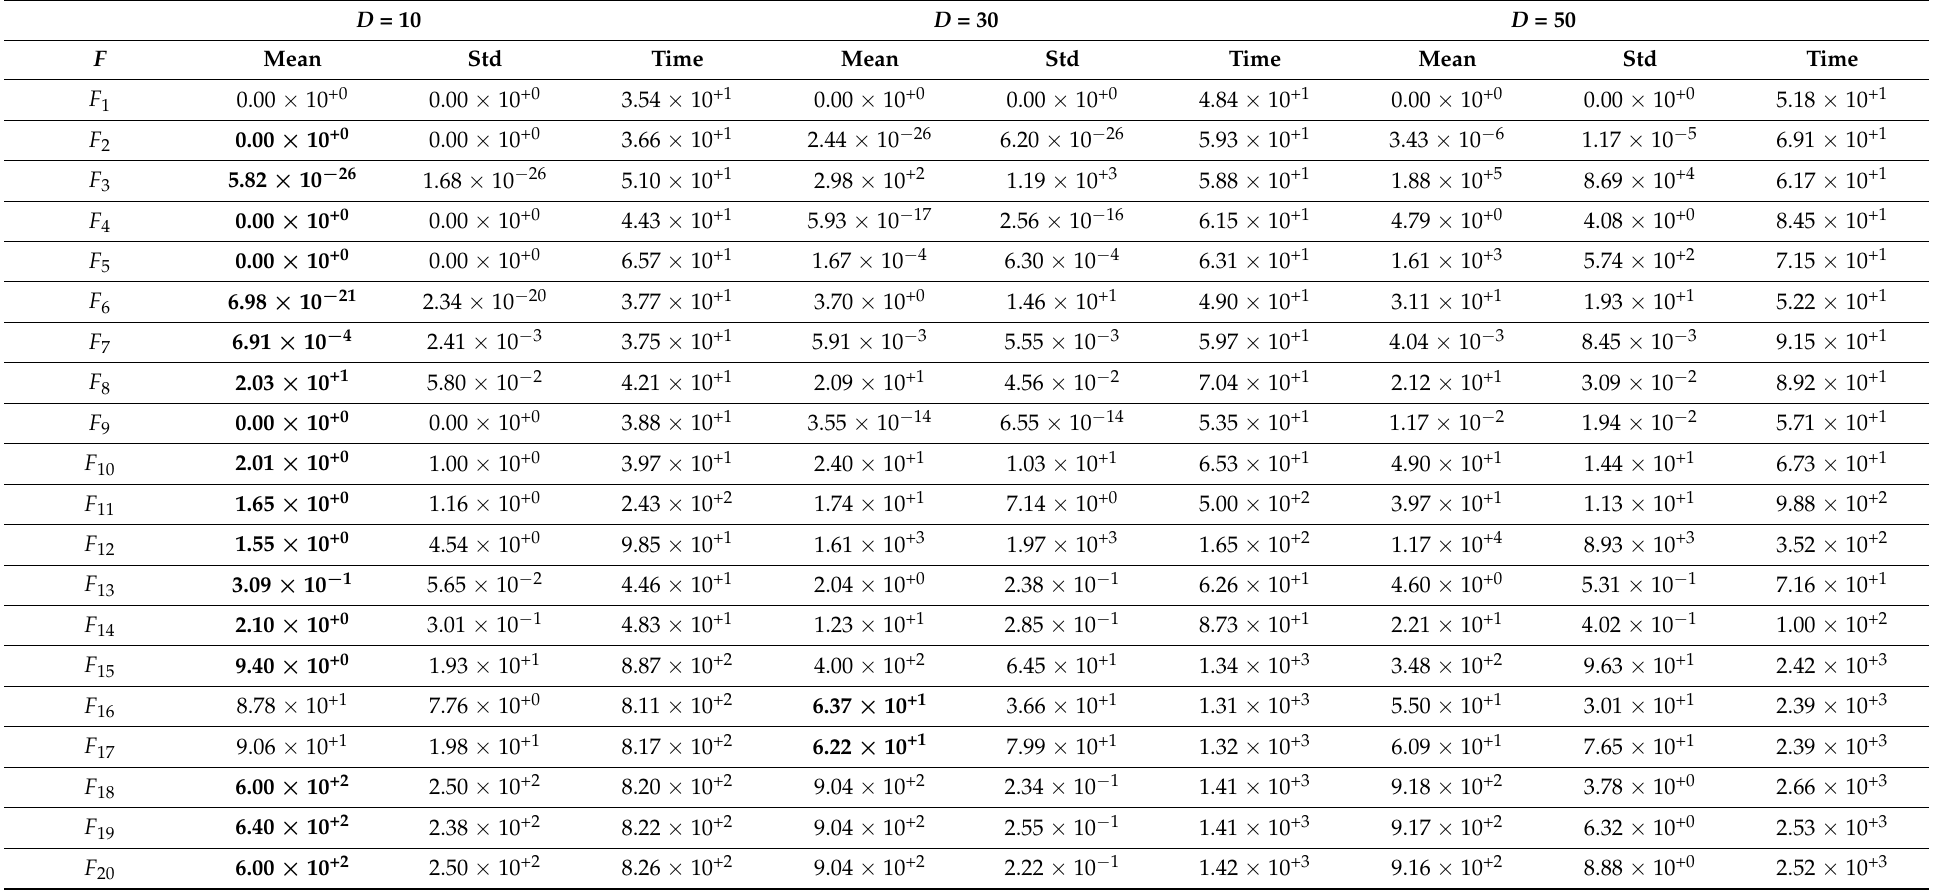
Table 5. Comparison with the reference algorithm for dimensions D = 10, 30,